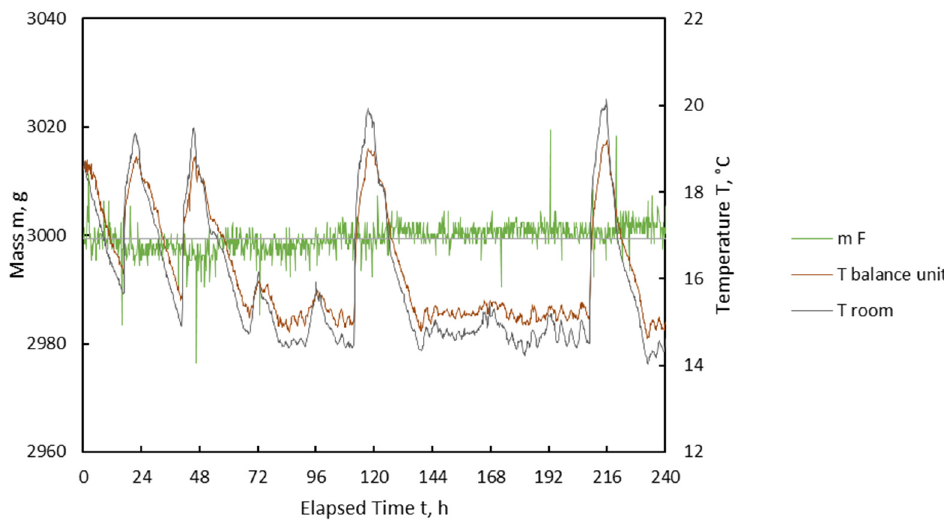
Figure 6. Temperature and mass vs. time; room temperature (T room ), temperature in balance unit (T balance unit ) and sample mass of precision drying zone (m P1 , m P2 , m P3 ) in the HPD TF3+ during cali- bration. Table 3. Parameters during calibration of the electronic balances in the HPD TP3+.